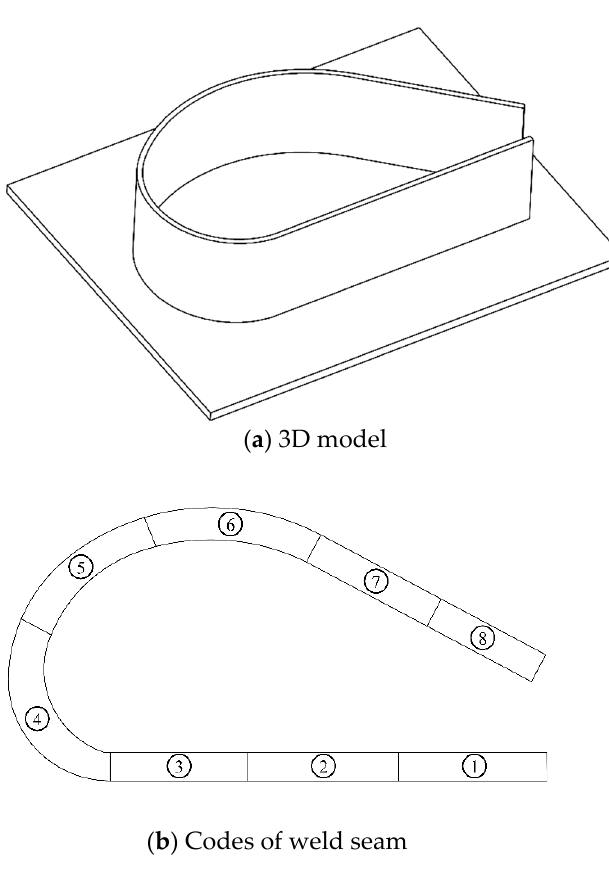
Figure 10. Weld seam coding of four welded structure 4.